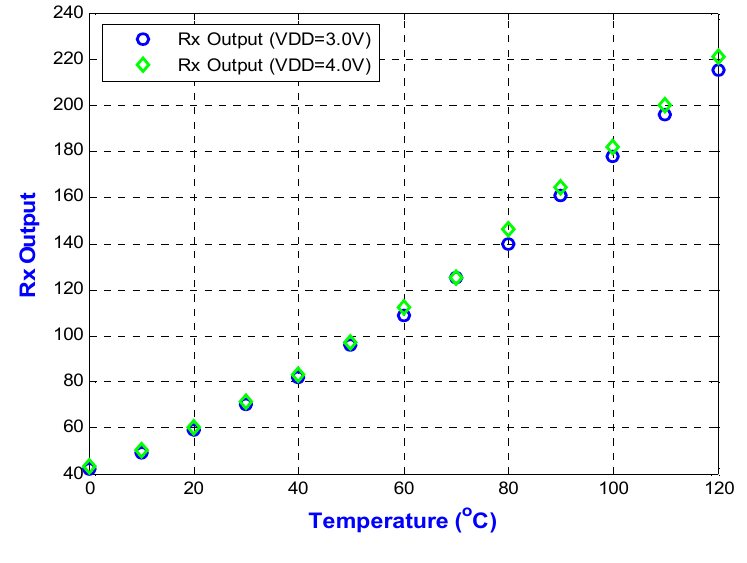
Figure 18. RX output with temperature signal processing.